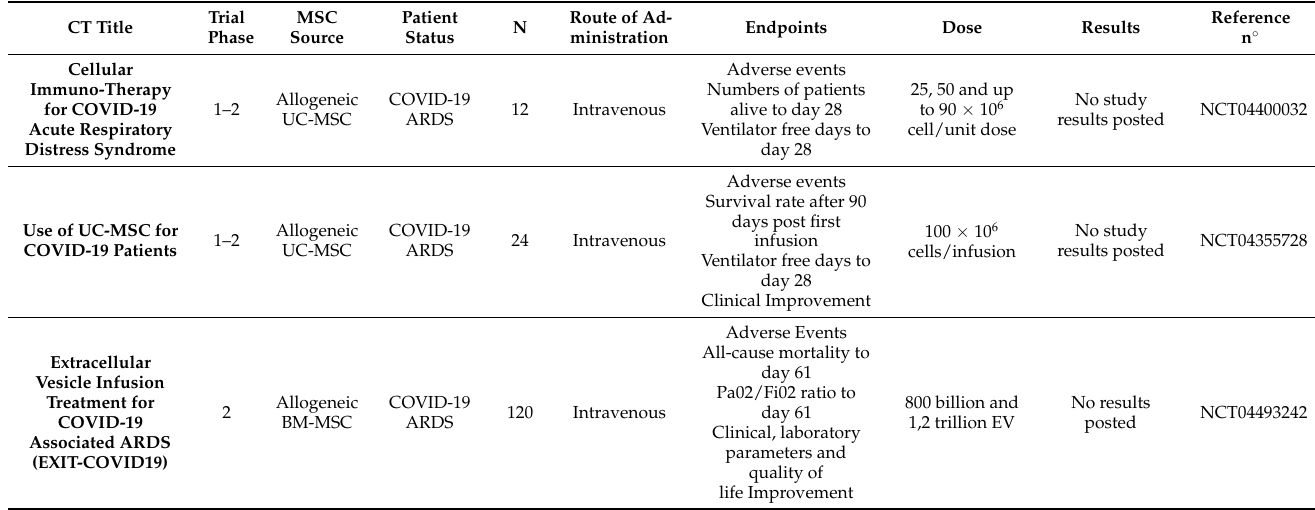
Table 2. Completed clinical trials assessing the safety and efficacy of MSC and MSC-derived extracellular vesicles therapy in ARDS secondary to